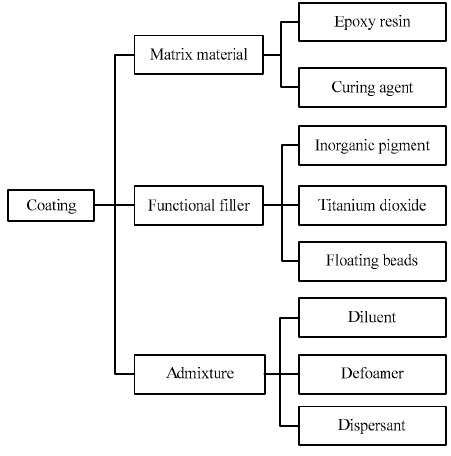
Figure 3. Composition of the coating material.